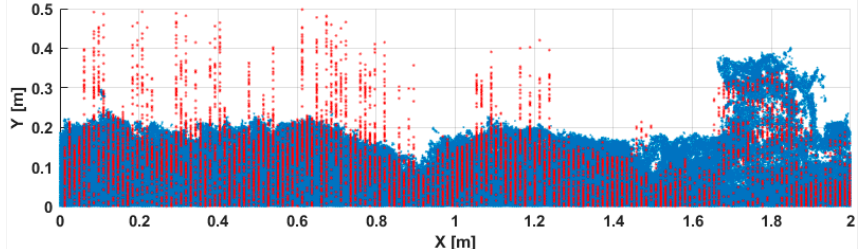
Figure 10. Comparison of point clouds from terrestrial lidar (red) and UAS photogrammetry (blue) in a top view (left side of the canopy).